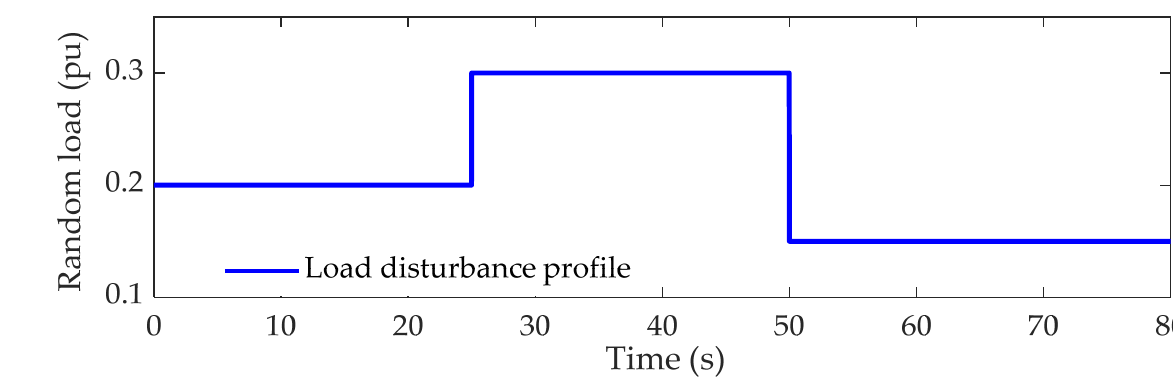
Figure 12. Random load profile.